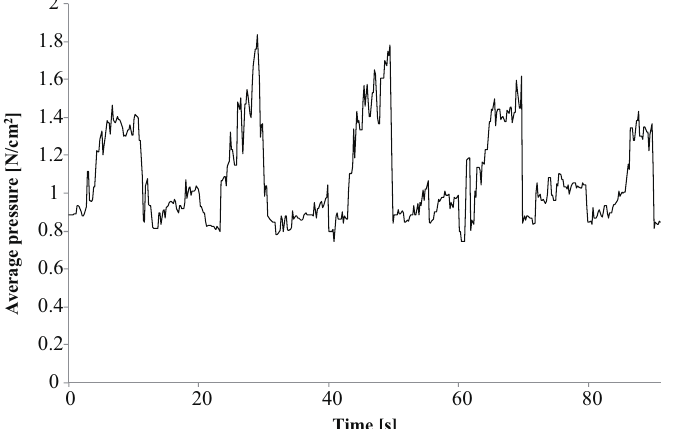
Figure 11. Data from one participant’s session showing average pressure used to detect a hug with the